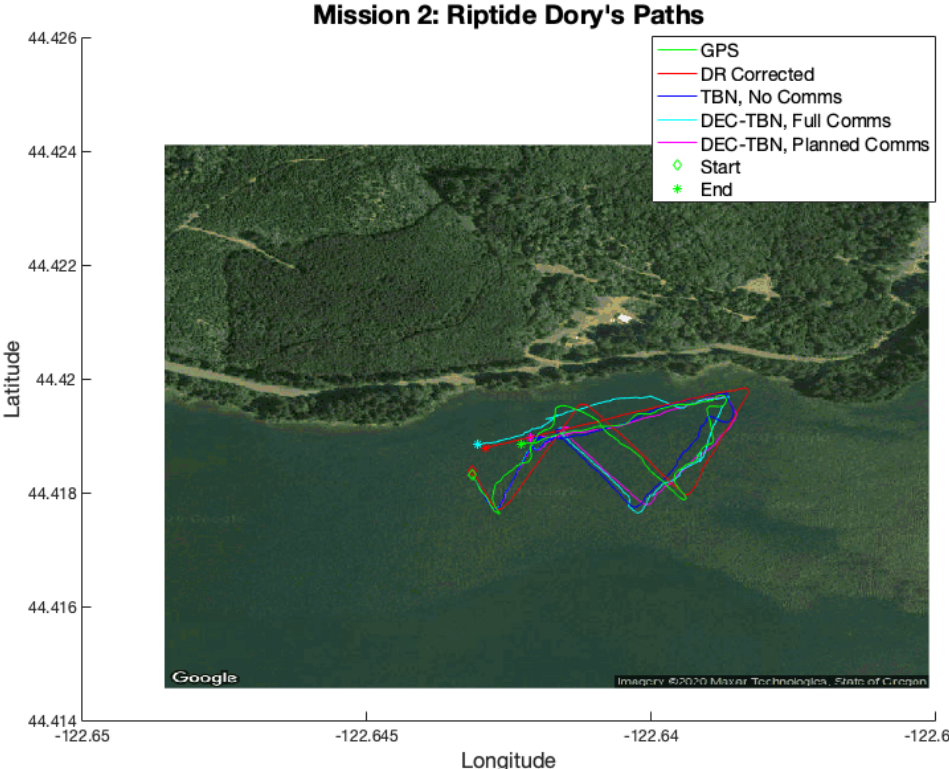
Figure 16. Dory’s paths from Mission 2. A gap in altimeter data is responsible for the straight section of the TBN paths that parallel the GPS and dead reckoning